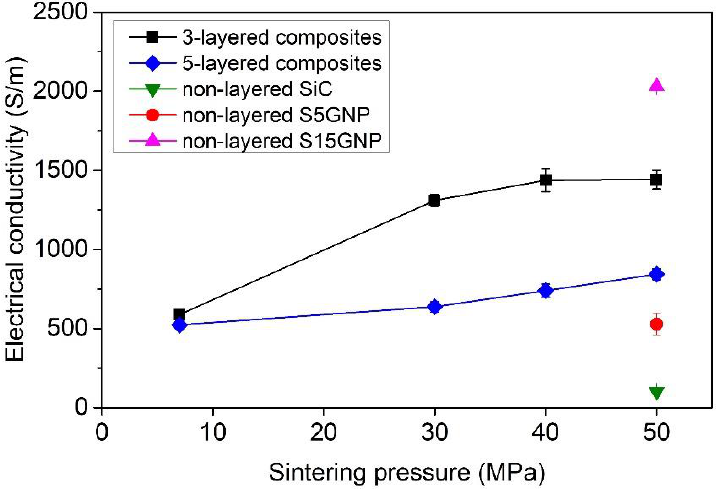
Figure 7 . Influence of applied pressure during sintering on the electrical conductivity of 3- and 5- layered composites from S15GNP layer side and comparison with non-layered composites SiC, SiC with 5 wt.% and SiC with 15 wt.% of GNPs.